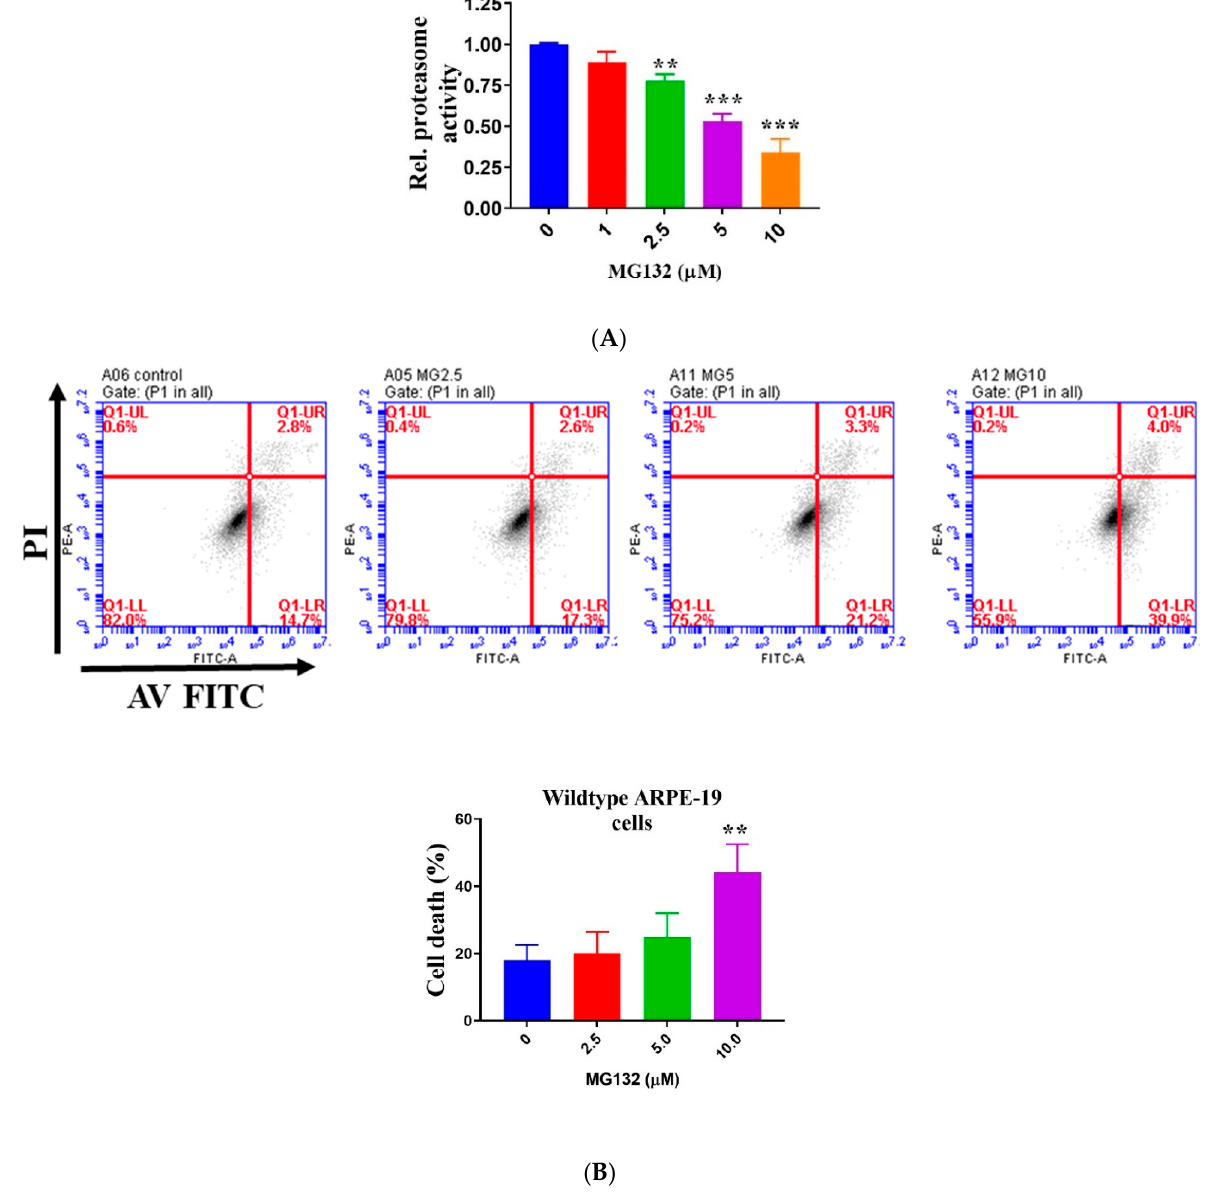
to the controls.